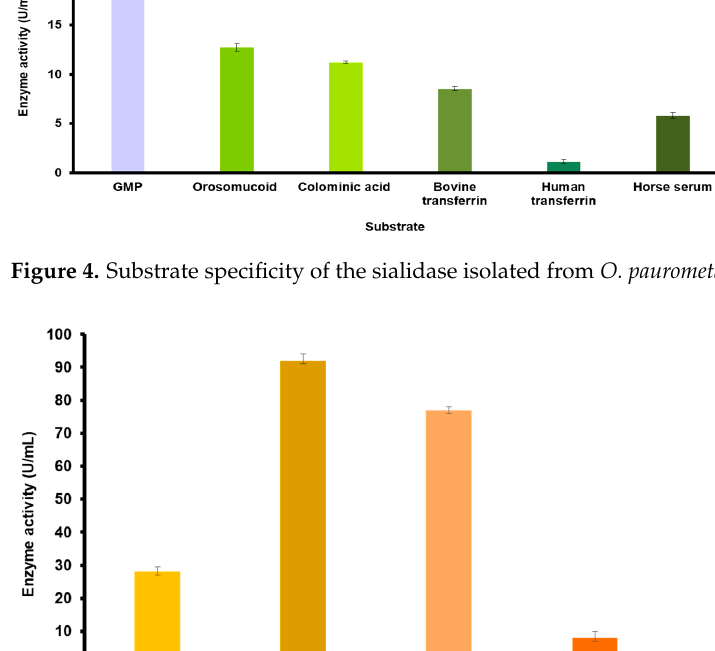
( b ) ( c ) Figure 3. Sialidase of O. paurometabola O129 (marked by arrow), shown by SDS-PAGE in a 10% sep- arating polyacrylamide gel. The enzyme was stained either by silver staining ( a , b ) or by the use of the Pierce™ Glycoprotein Staining Kit (Thermo Scientific Inc., Waltham, MA, USA), ( c ). Lanes and samples: ( a ): 1, molecular weight marker; 2–4, crude enzyme obtained after (NH 4 ) 2 SO 4 precipitation, dialysis, and purification through a DEAE cellulose column; ( b ): 1, molecular weight marker; 2, entirely purified sialidase of O. paurometabola O129; ( c ): 1, molecular weight marker; 2, purified si- alidase after glycoprotein staining. The characteristic magenta color, which the purified protein ac- quired as a result of Schiff base staining, reveals the very likely presence of a glycosyl moiety. As a molecular weight marker, we used the Perfect TM Tricolor Protein Ladder (EURx, Gdansk, Poland). The determination of the molecular weight of the purified sialidase was performed by the estima- tion of the relative mobility factor (Rf). The decimal log value corresponding to this Rf is approxi- mately 70 kDa. 2.2. Biochemical Characterization of the Enzyme 2.2.1. Substrate Specificity